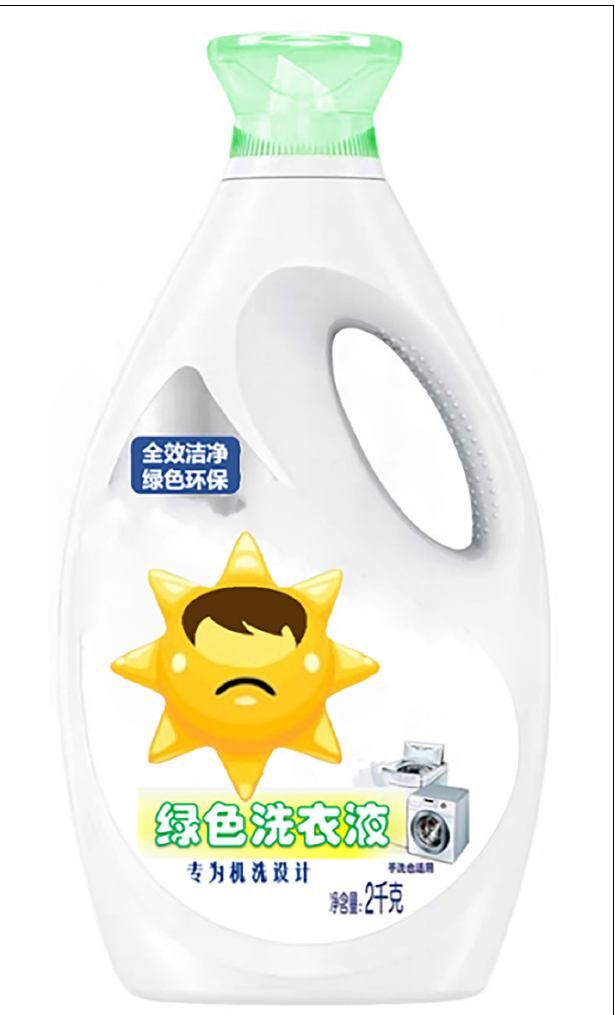
FIGURE 8 | Anthropomorphic strategy of sad expressions with eyes.